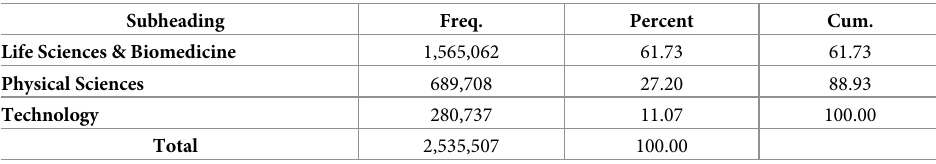
Table 5. Subheading